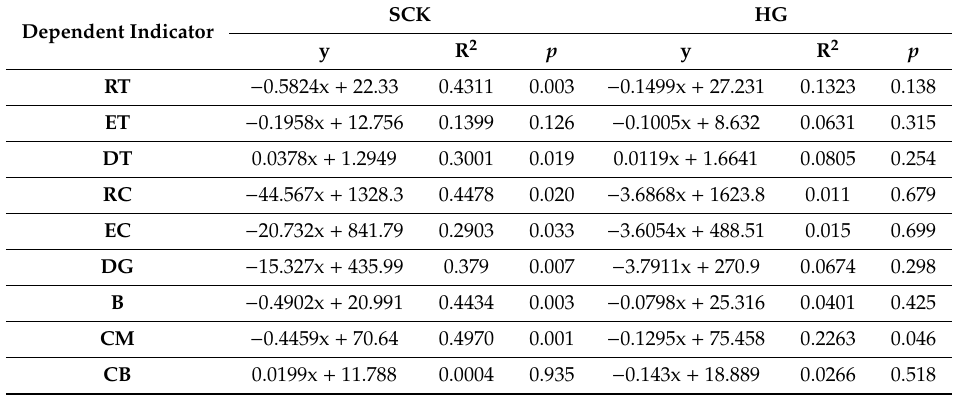
Table 3. Evaluation of changes in RumiWatch noseband sensor readings observed in summer 2020 in Lithuania by day of the experiment (independent indicator) using linear